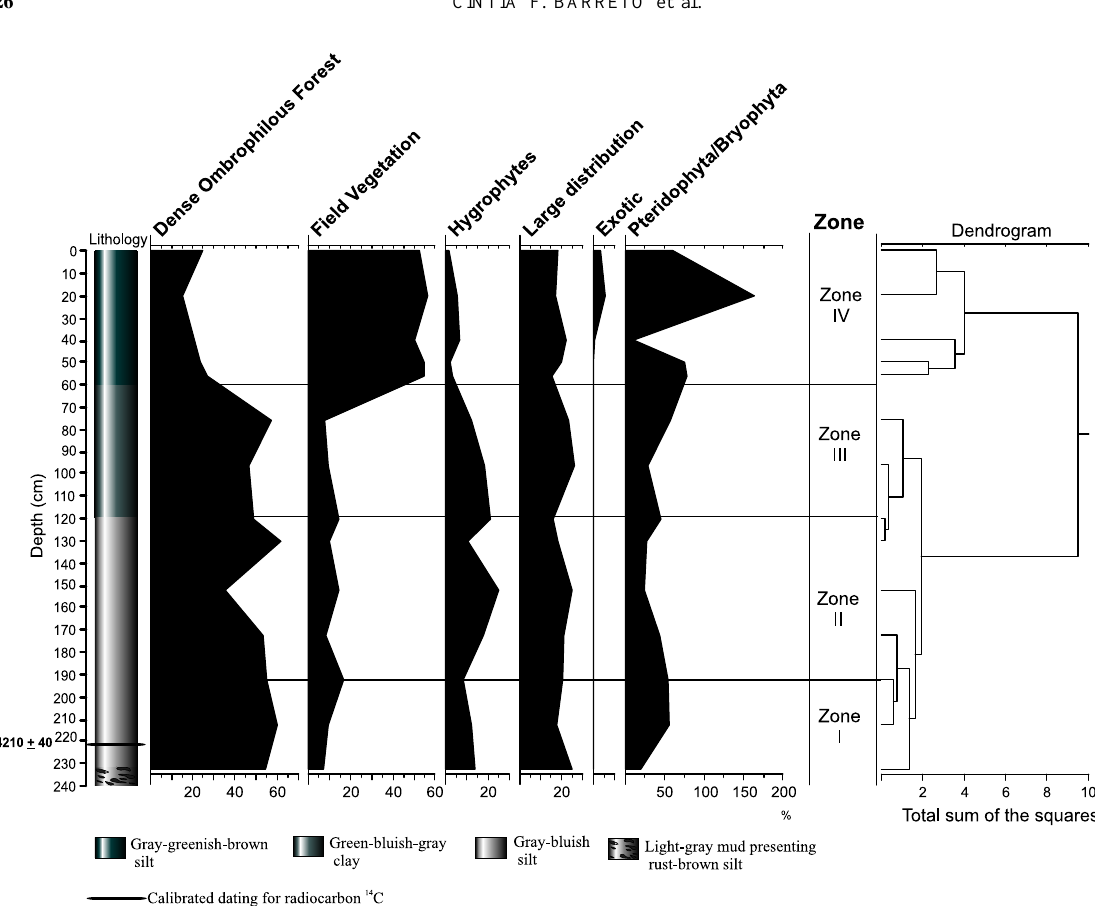
Fig. 2 – Percentage palynodiagram of the ecological groups